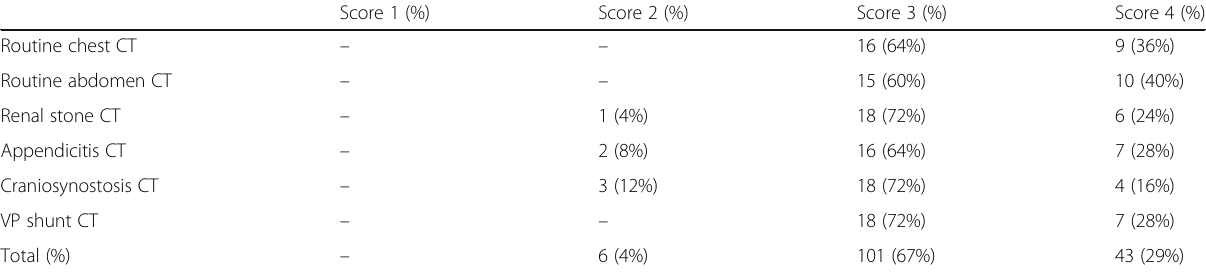
Table 4 Frequency of subjective image quality score (1 – 4) for the five radiologists